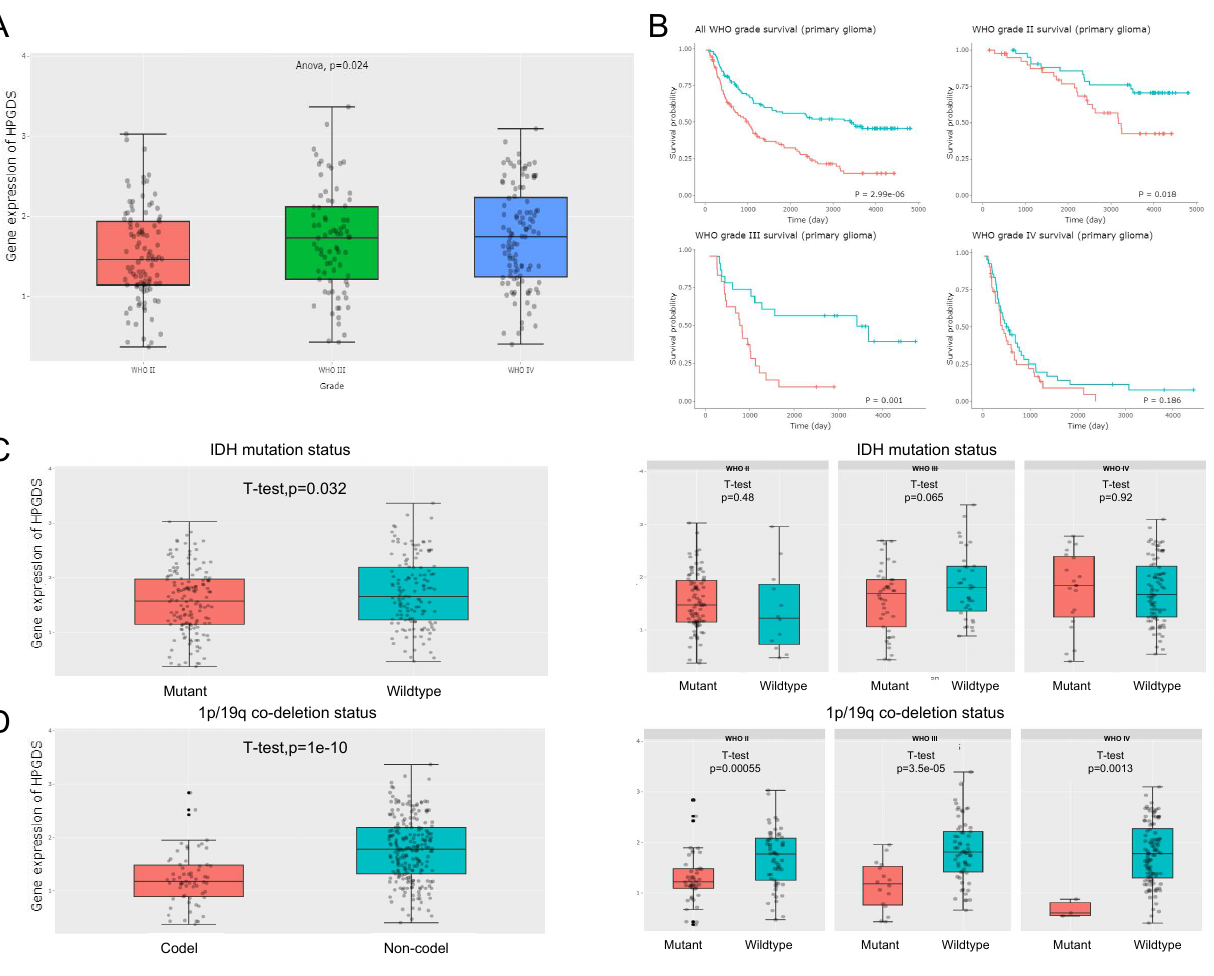
Figure 6. Effects of microwave pretreatment on the composition and content of phytosterols in rapeseed oil. Values are the means standard deviations; n = 3 parallel determinations. a–d Mean ± values (a > b > c > d, corresponding to the same parameter) not followed by a common letter differ significantly ( p <